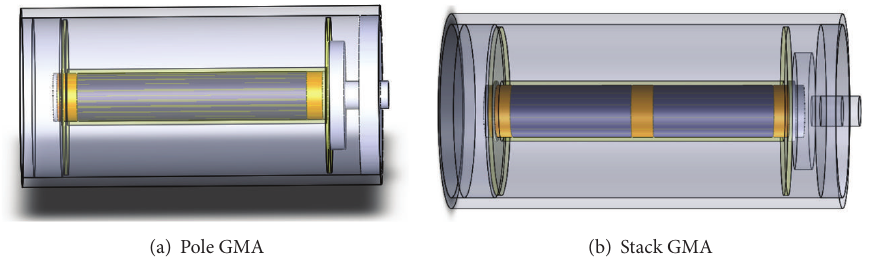
Figure 1: 3D model of pole GMA and stack GMA.